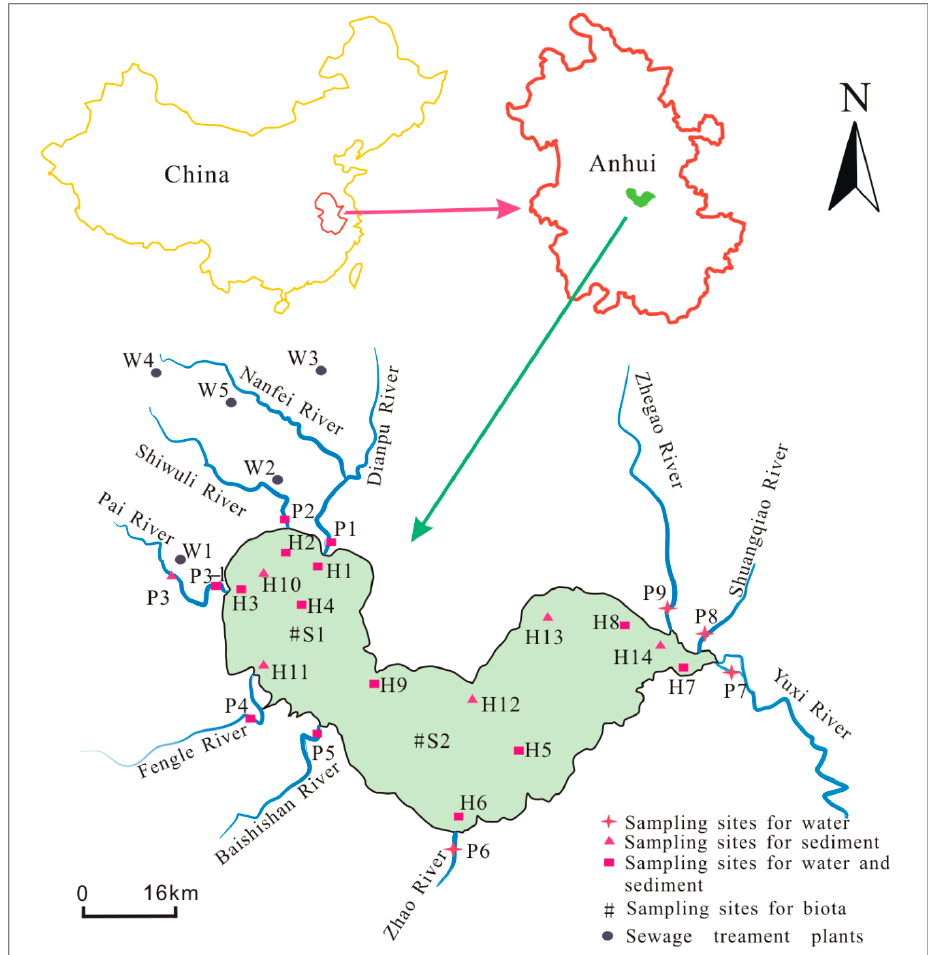
Figure 1. Maps of the sampling sites in Chaohu Lake basin, China.